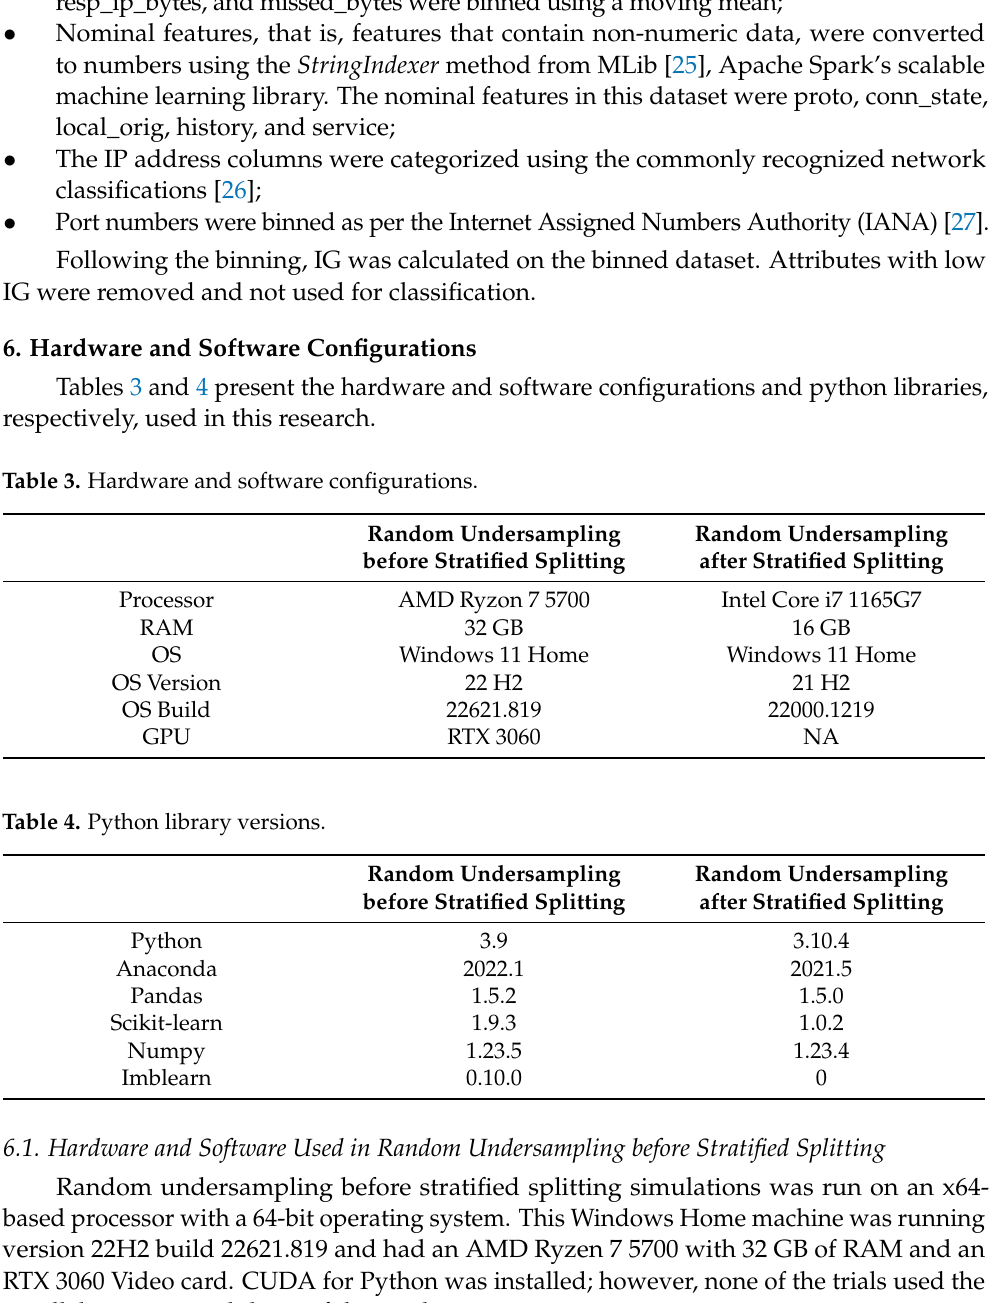
Table 3. Hardware and software configurations.